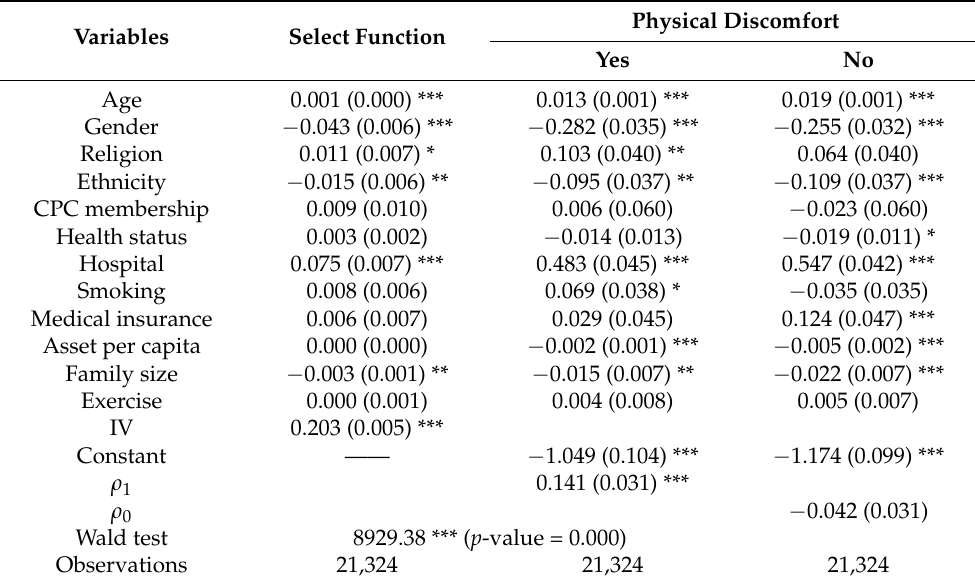
Table A3. The ESP model estimation for the effect of non-traditional fuel choices on Physical discomfort.